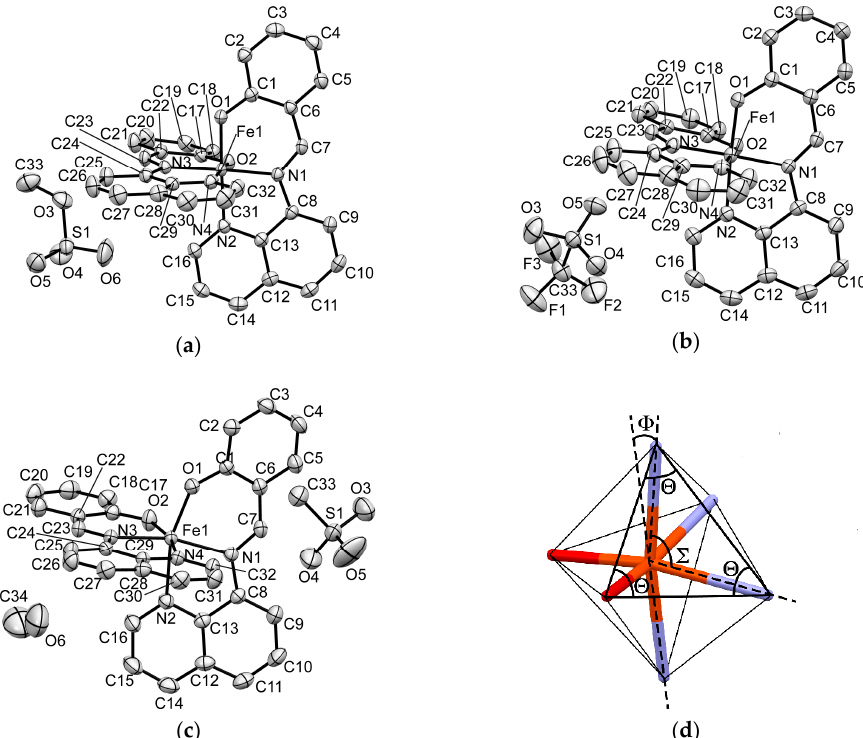
Figure 6. ORTEP drawings of 50% probability with atomic numberings for the [Fe(qsal) 2 ] cation, counter anion, and solvate molecule at 293 K for 1 ( a ); for 2 ( b ); for 3 ( c ). Hydrogen atoms are omitted for clarity; ( d ) The angles of a coordination octahedron concerning the distortion parameters.